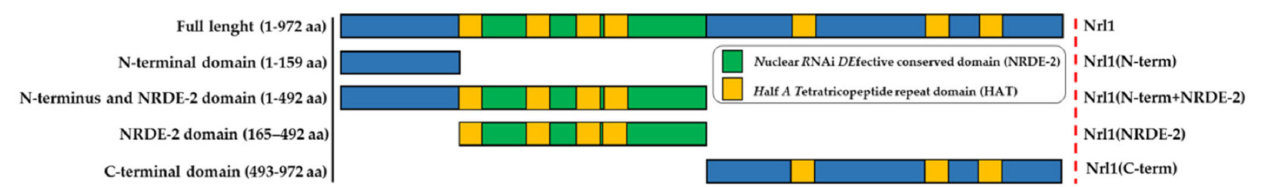
Figure 2. Schematic representation of known Nrl1 domains and motifs and the regions that were